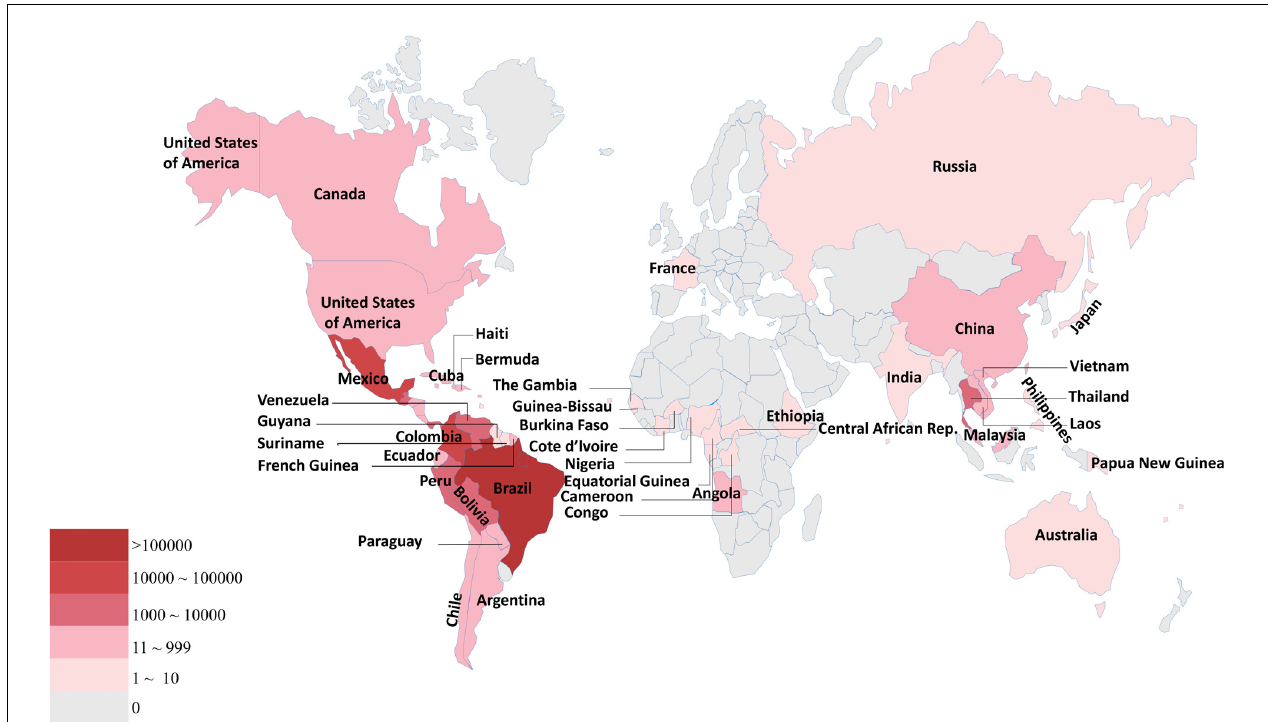
FIGURE 1 | Summary of ZIKV morbidity statistics with country- and quarter-level panel data. The deeper the color, the higher the number of infected